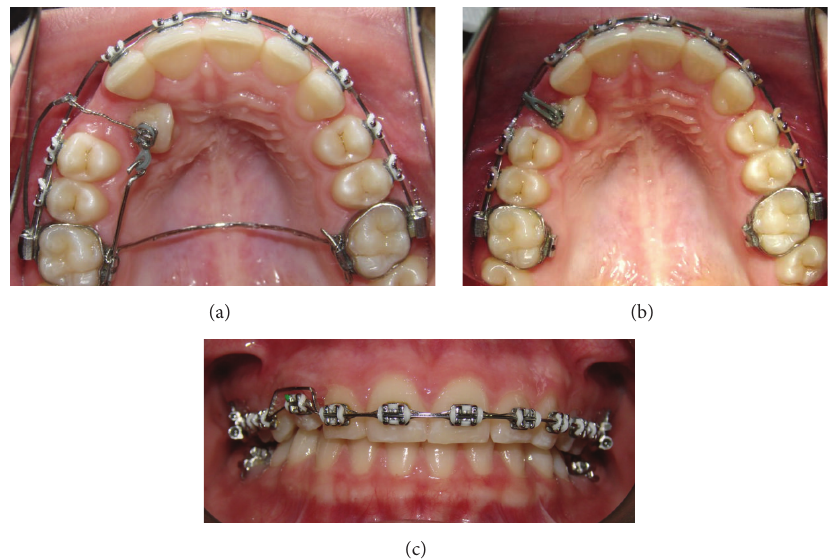
Figure 5: Intraoral photographs. Mechanism of action of the two cantilevers acting together (a). Removal of the transpalatal arch and cantilever coupled to the tube (b). Bypass in the region of upper right canine and round wire assisting in the mechanical forces (c).